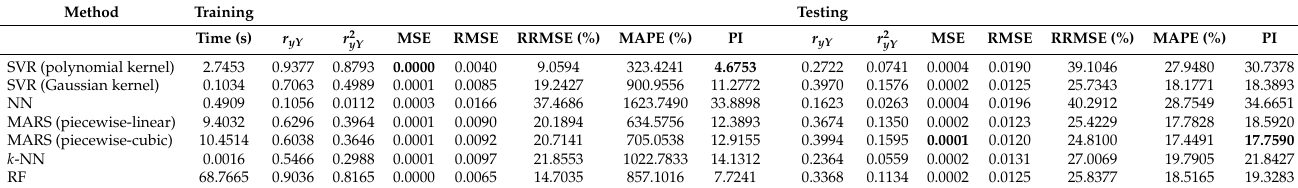
Table 6. Performance of the machine learning methods in carbon prediction based on static